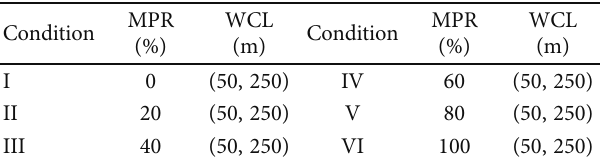
Table 7: Parameter settings of six numerical